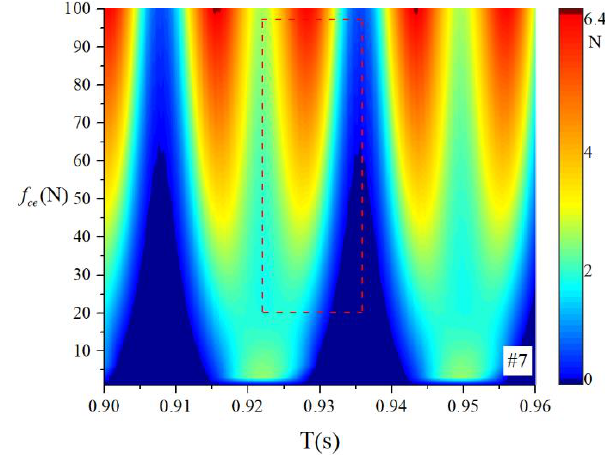
Figure 21. Waterfall of the rolling element – raceway contact force (#7).